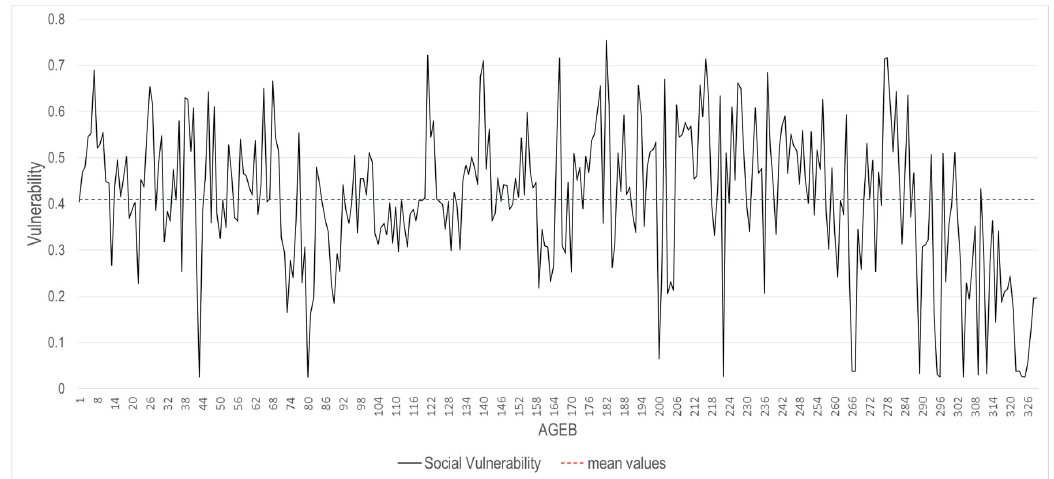
Figure 3. Social vulnerability values for the studied AGEB.